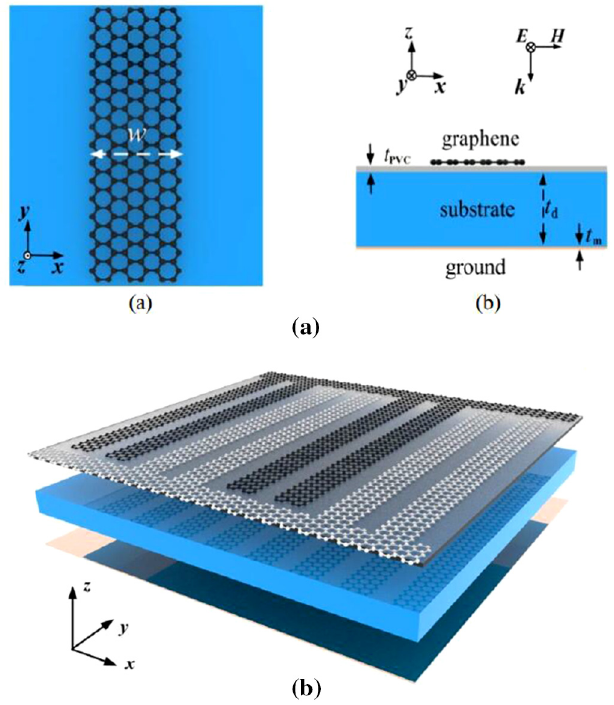
Fig. 11. (a) The con fi guration of the unit cell of the graphene ribbons. (b) The con fi guration of the graphene ribbon